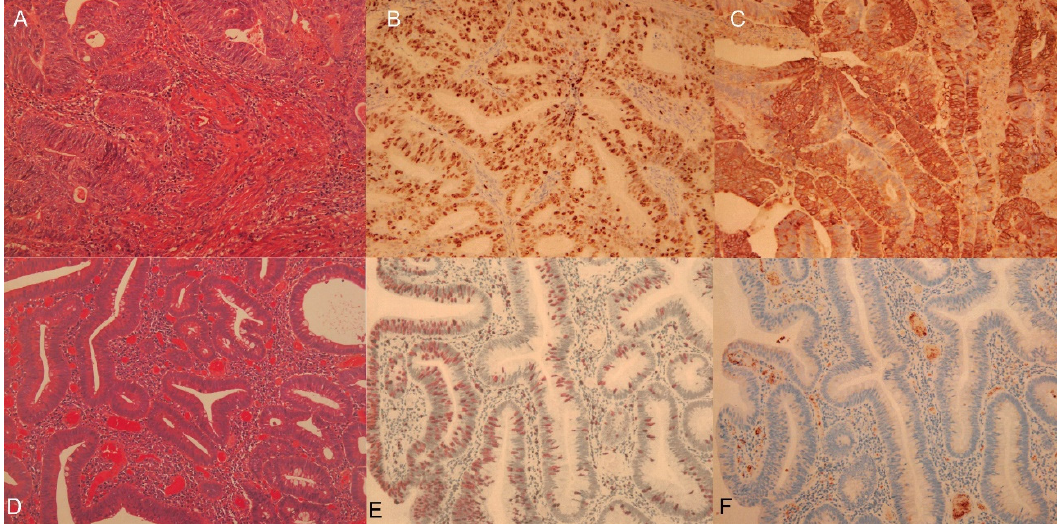
Figure 2. Pathological features of colorectal cancer and adenoma. ( A ) Hematoxylin and Eosin (HE) staining in CRC (moderately differentiated tubular adenocarcinoma), ( B ) Ki-67 staining in CRC (Ki-67 index: 84%), ( C ) GLUT-1 staining in CRC, ( D ) HE staining in colon adenoma (tubular adenoma with moderate to severe atypia), ( E ) Ki-67 staining in colon adenoma (Ki-67 index: 23%), and ( F ) GLUT-1 staining in colon adenoma. Immunohistochemical expression of GLUT-1 and Ki-67 were clearly confirmed in CRC. In colon adenoma, Ki-67 was less intense but GLUT-1 expression was quite low despite the high FDG uptake.